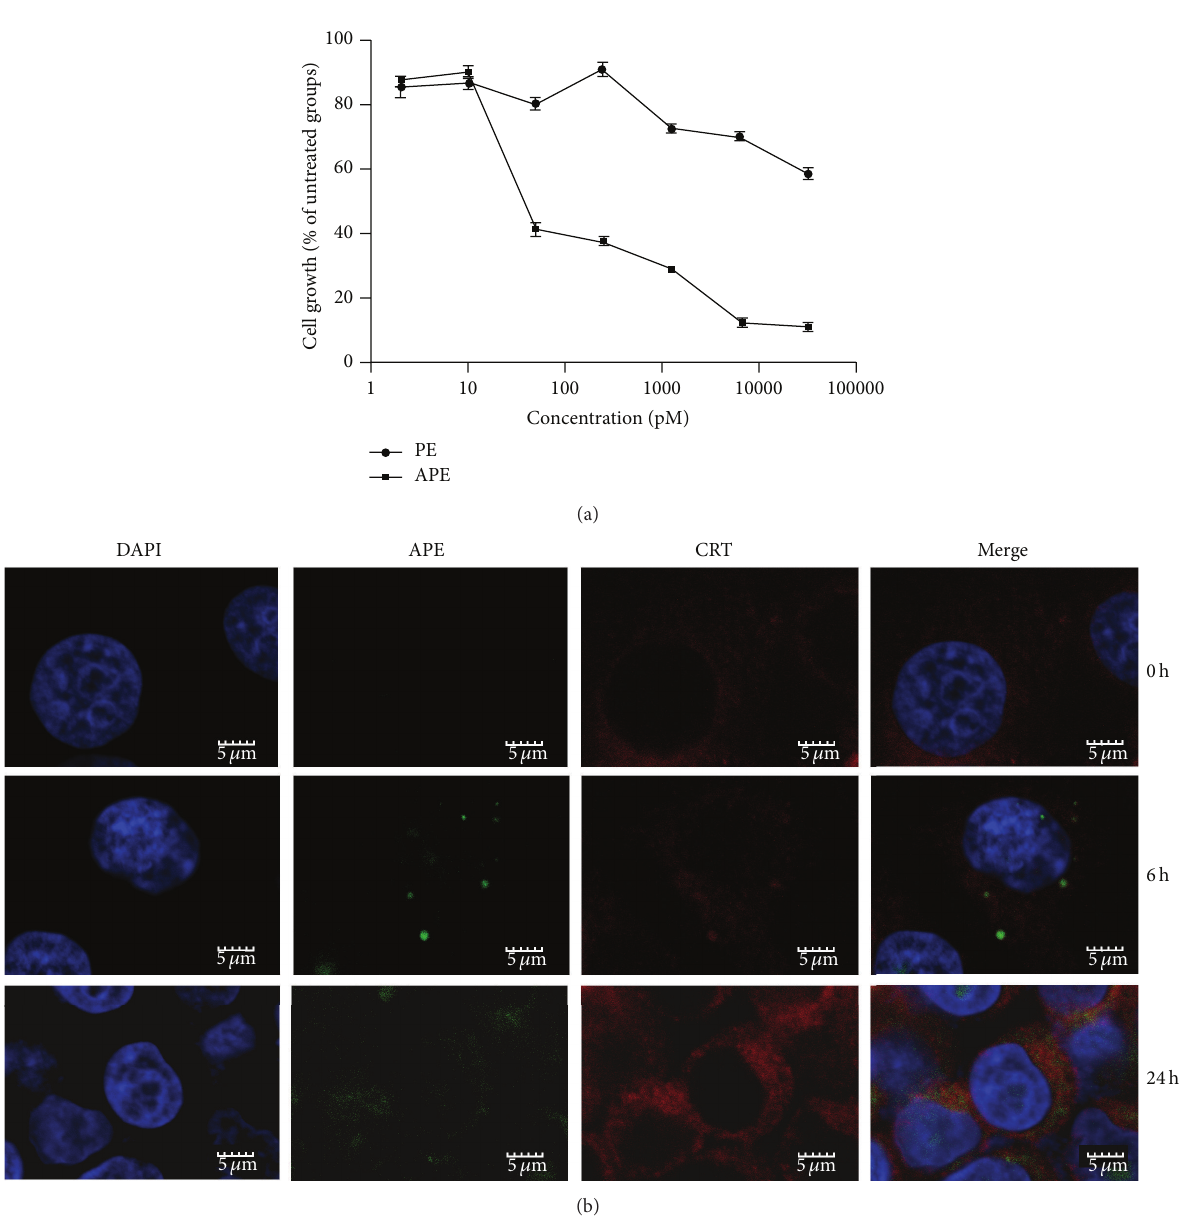
Figure 6: Cytotoxicity and localization of the immunotoxin. (a) HHCC cells were incubated with different concentrations (0.002, 0.01, 0.05, 0.25,1.25,6.5,and32.5 nM)oftheimmunotoxinfor72h,andcellgrowthwasmeasuredbyMTTassay.(b)Thelocalizationoftheimmunotoxin was observed by laser scanning confocal microscopy at different incubation times (0, 6, and 24h). DAPI indicates the cell nucleus; APE represents the immunotoxin; CRT is the calprotectin. All data are expressed as means ± standard deviations